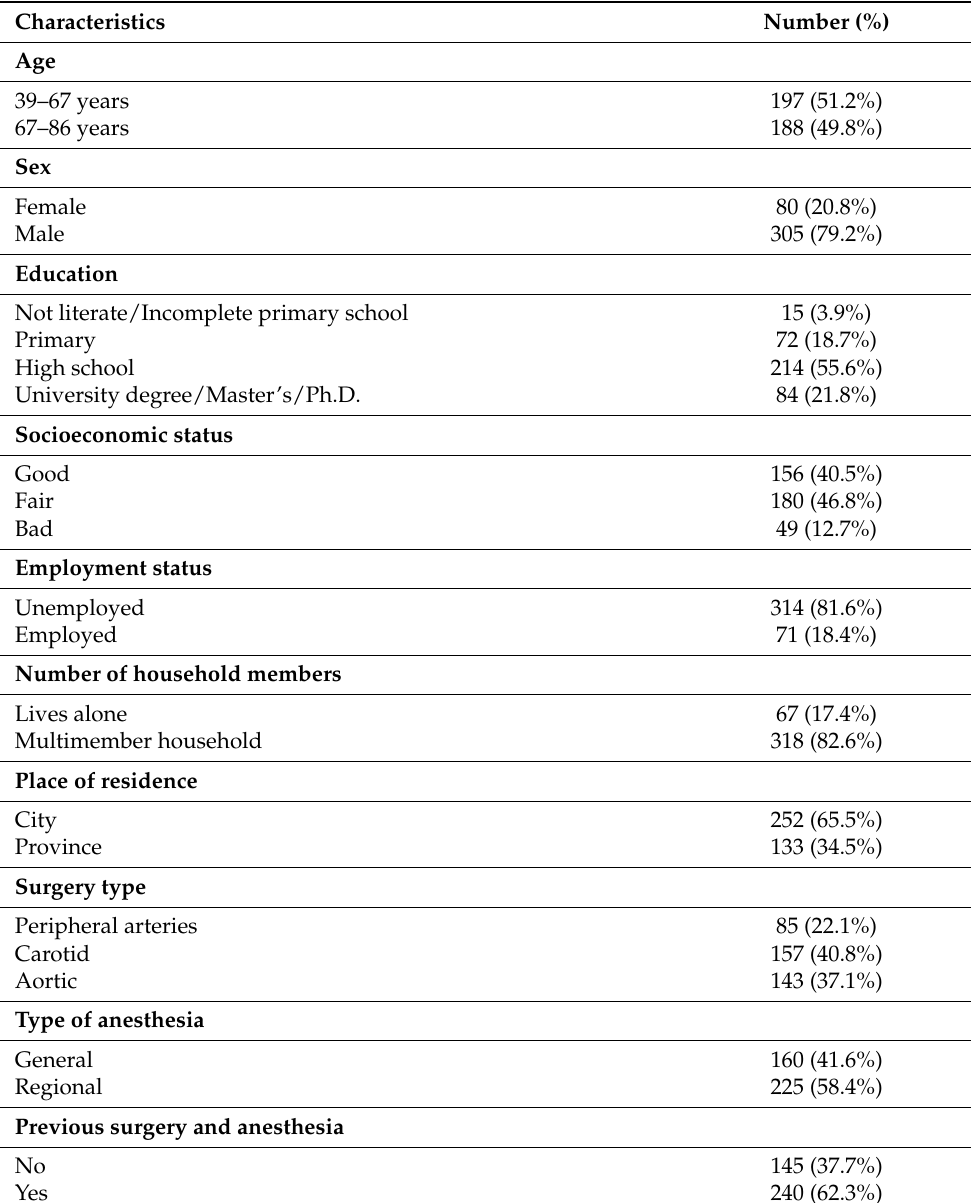
Table 1. Basic demographic and clinical characteristics of